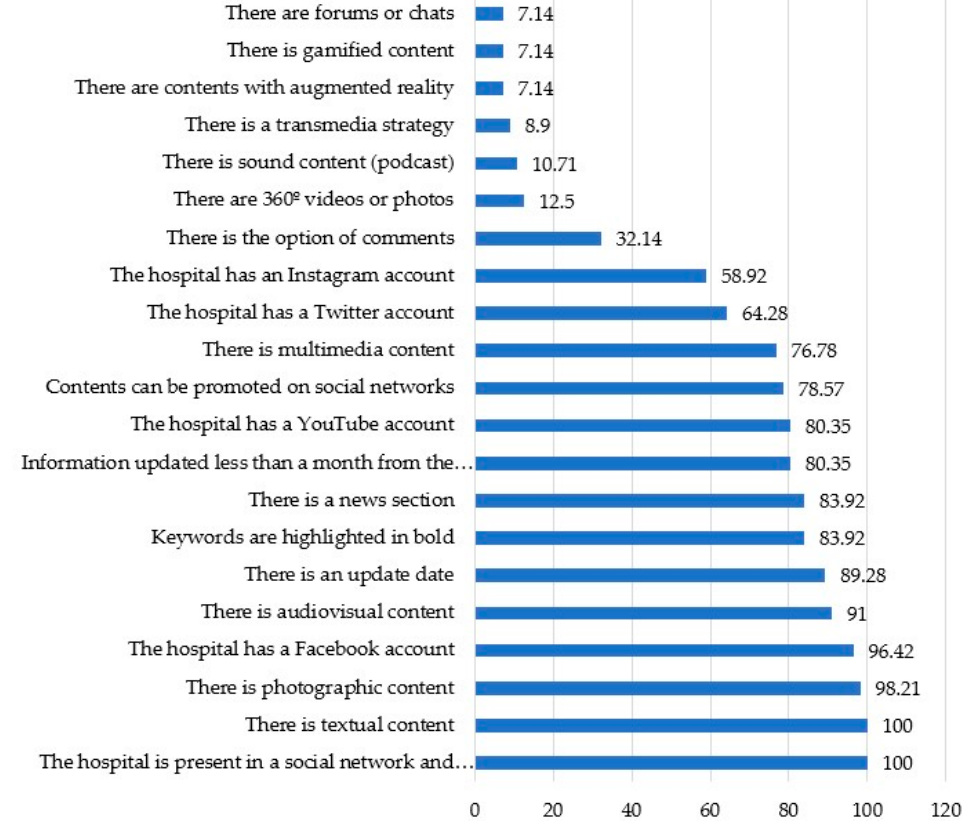
Figure 8. Social media and content updating. Own elaboration.